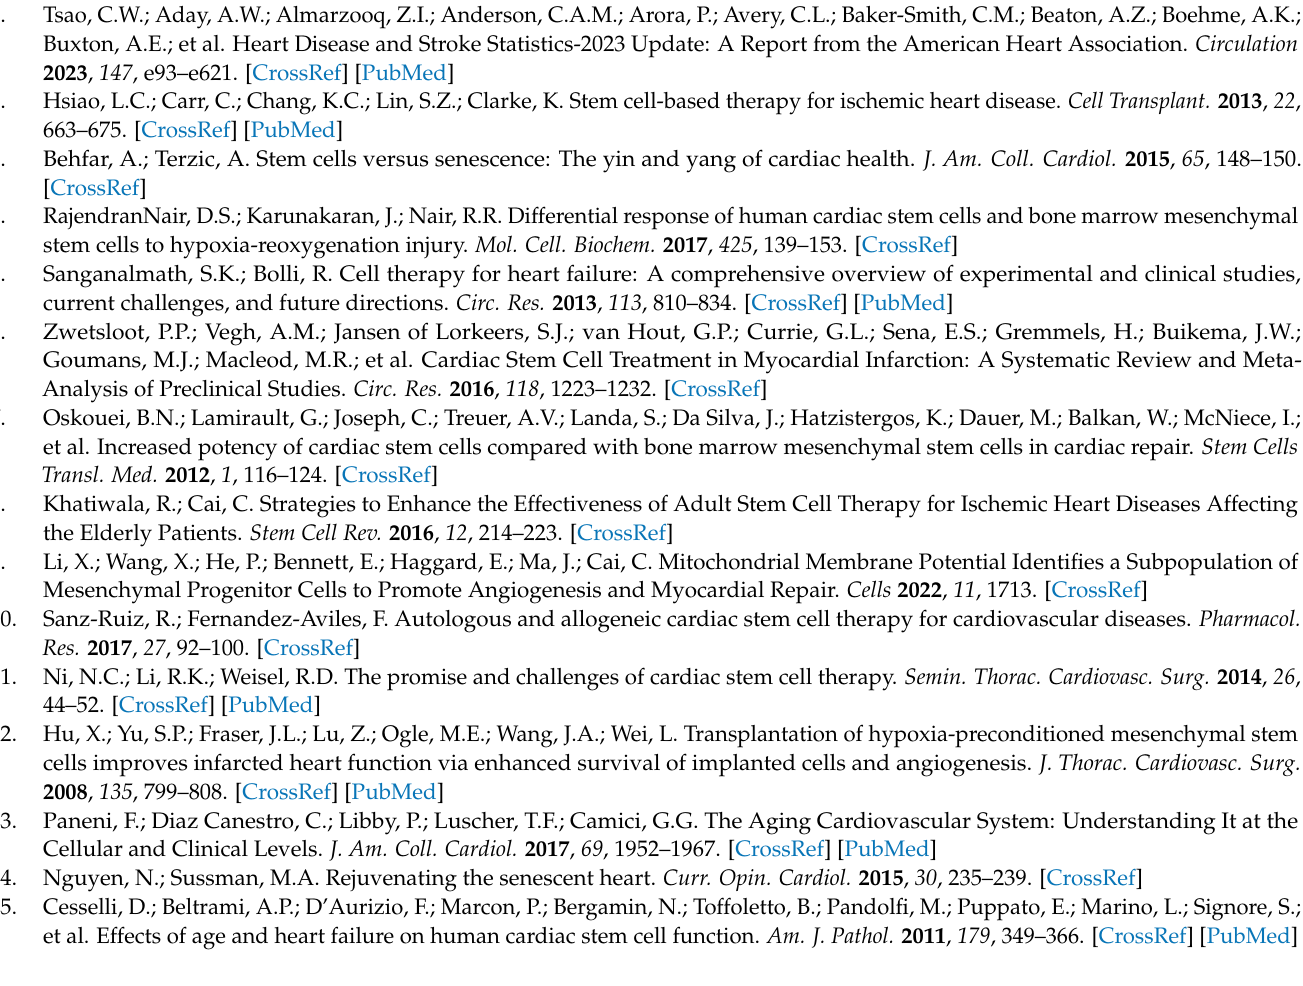
Table S2: List of antibodies against human proteins used for the Western